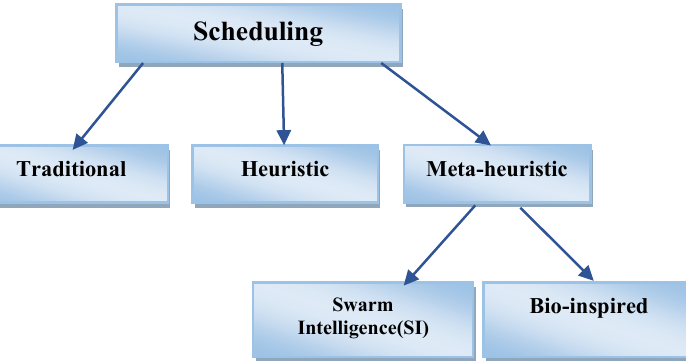
Figure 4. Task scheduling